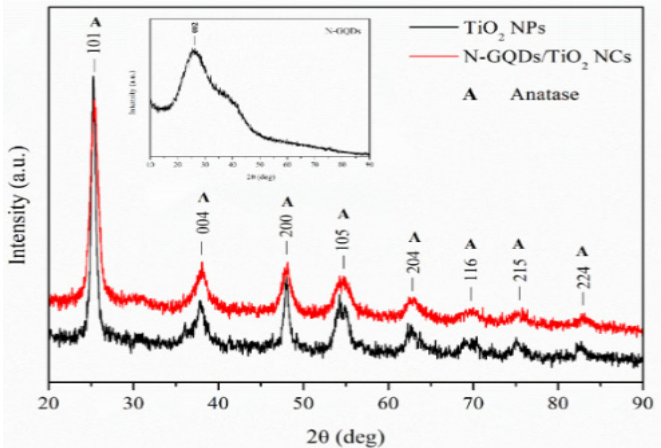
Figure 1. X-ray diffractograms synthesized TiO 2 NPs and N-GQDs/TiO 2 NCs. The inset shows the X-ray diffractograms of N-GQDs.